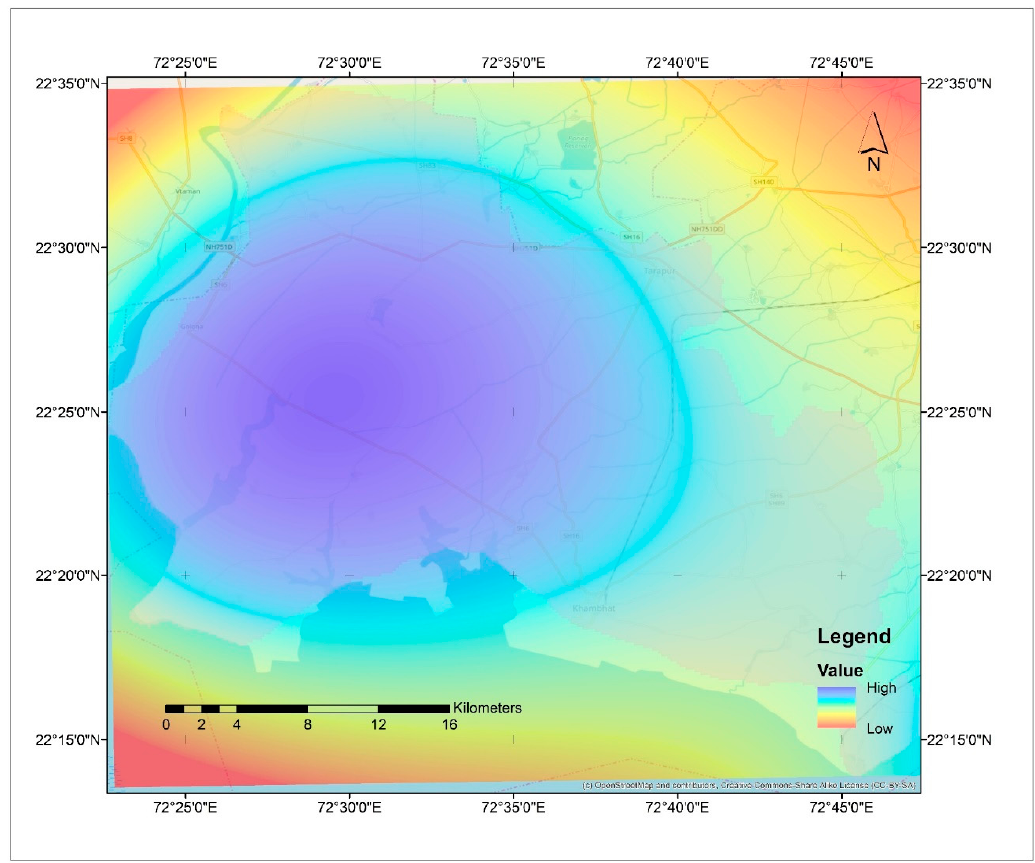
Figure 8. Spatial trend showing the conversion of barren land to agricultural land. Table 3. Statistical summary for various categories in land use/land cover maps for the years 2001 and 2011.